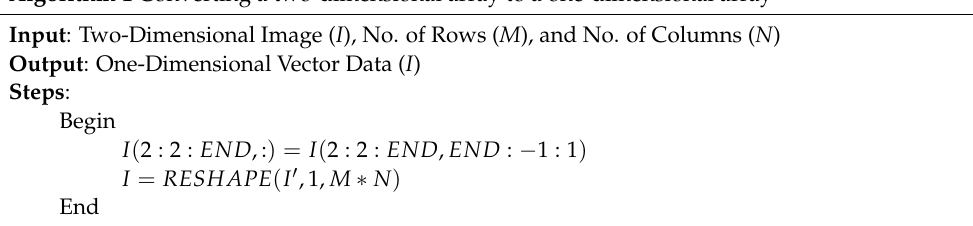
Algorithm 1 Converting a two-dimensional array to a one-dimensional array